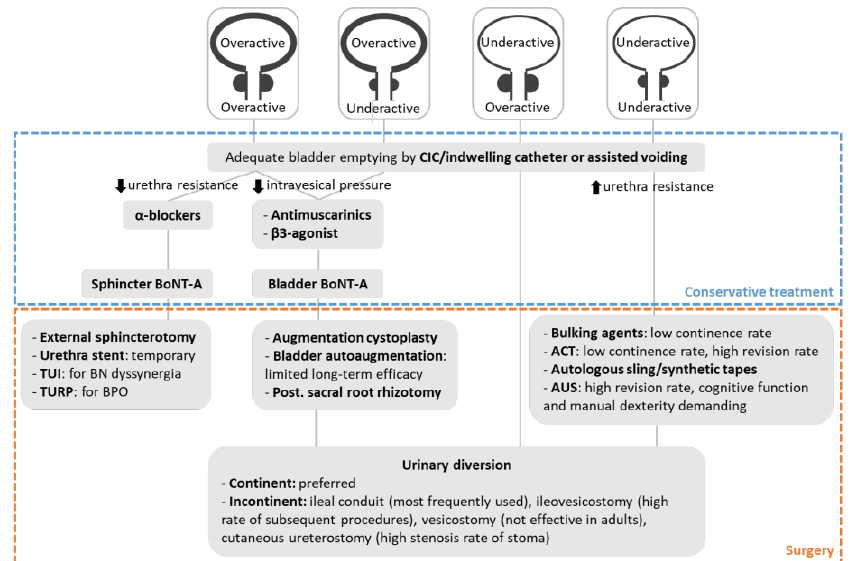
Figure 1. Algorithm of management of lower urinary tract dysfunction in patients with chronic spinal cord injury. BoNT-A, botulinum toxin A; TUI, transurethral incision; BN, bladder neck; TURP, Transurethral resection of prostate; BPO, benign prostatic obstruction; ACT, adjustable continence therapy; AUS, artificial urinary sphincter.